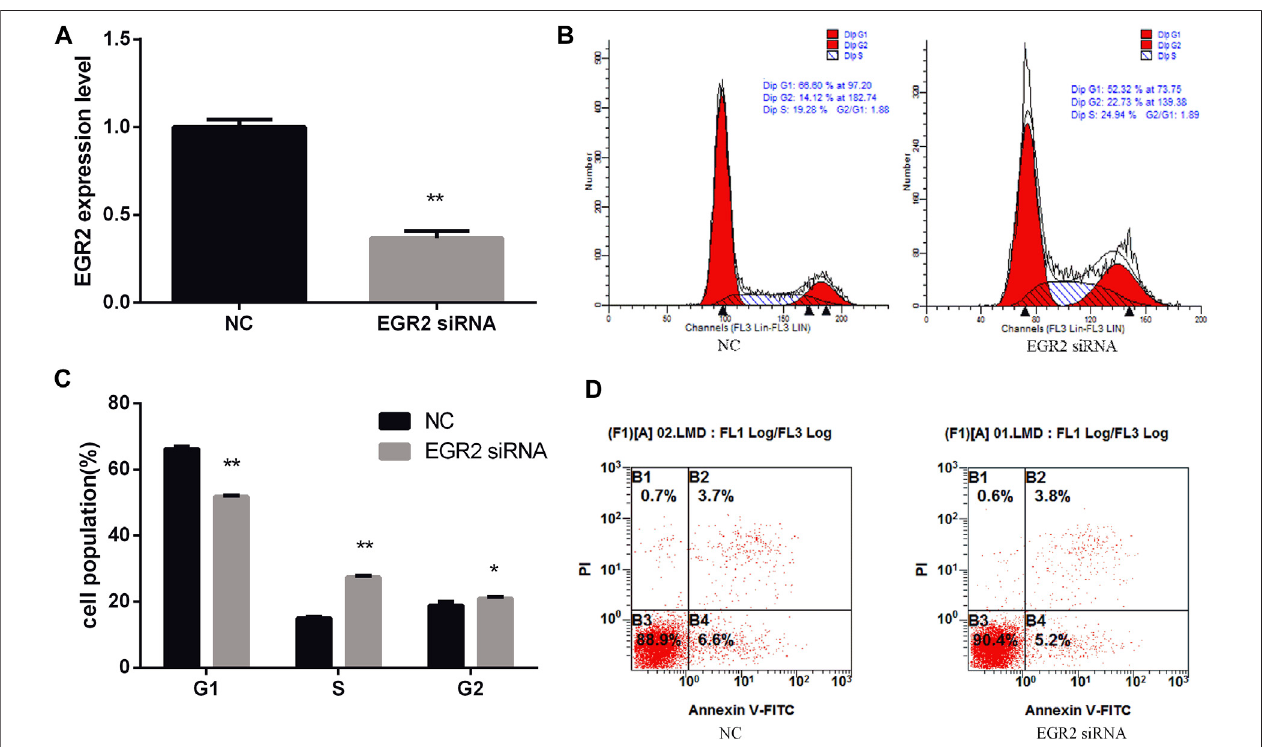
FIGURE 6 | Knockdown of EGR2 promotes BGC823 cell growth and inhibits cell apoptosis. (A) After knockdown of EGR2, the expression level of EGR2 was detectedbyRT-qPCR. (B) Cellcyclewereanalyzed by fl owcytometryafterbeingtransfectedwithEGR2siRNA. (C) Cellnumberstatisticsateachstageofcellcycle. (D) After knockdown of EGR2, cell apoptosis was detected by Annexin V-FITC reagent. Value in graphs represents means ± SD. At least three independent experiments were carried out. ** p < 0.01; * p <